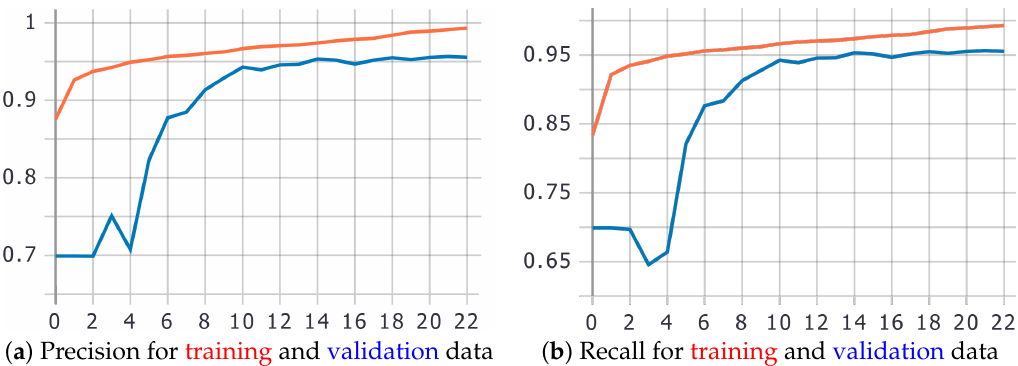
Figure 5. Learning curves—specificity and sensitivity among the epochs.